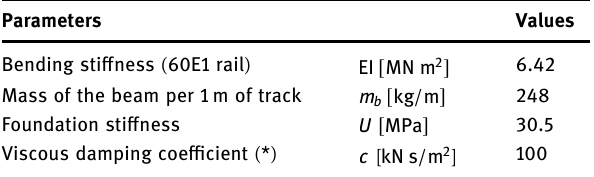
Table 5: Parameters of the ballast, blanket layer, and the subgrade for the comparative calculations